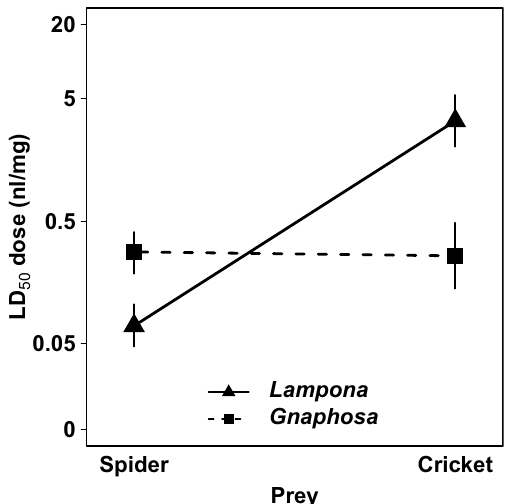
Figure 6. Comparison of median lethal doses (LD 50 ) of crude venoms of Lampona and Gnaphosa spiders on two prey types measured 24 h after venom injection. Vertical lines represent 95% confidence